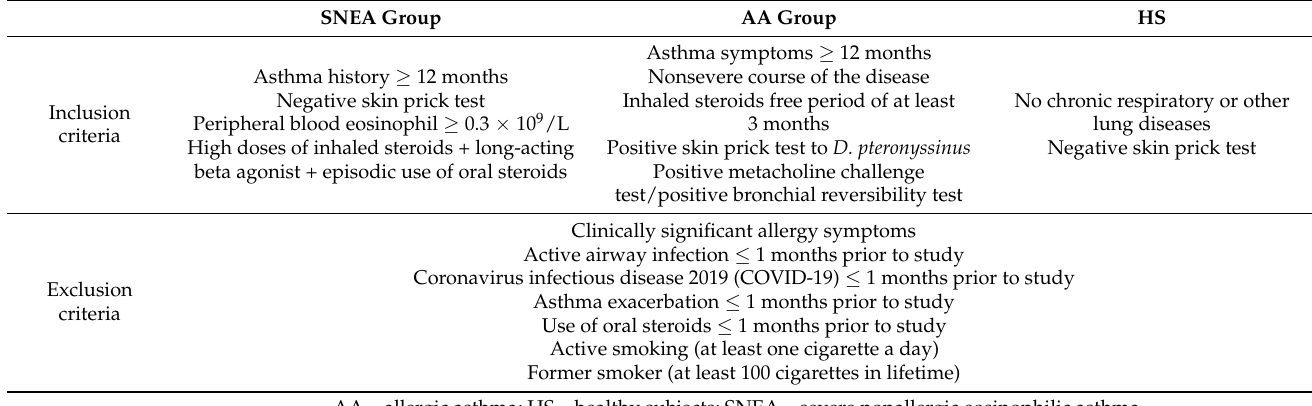
Table 1. Inclusion and exclusion criteria.